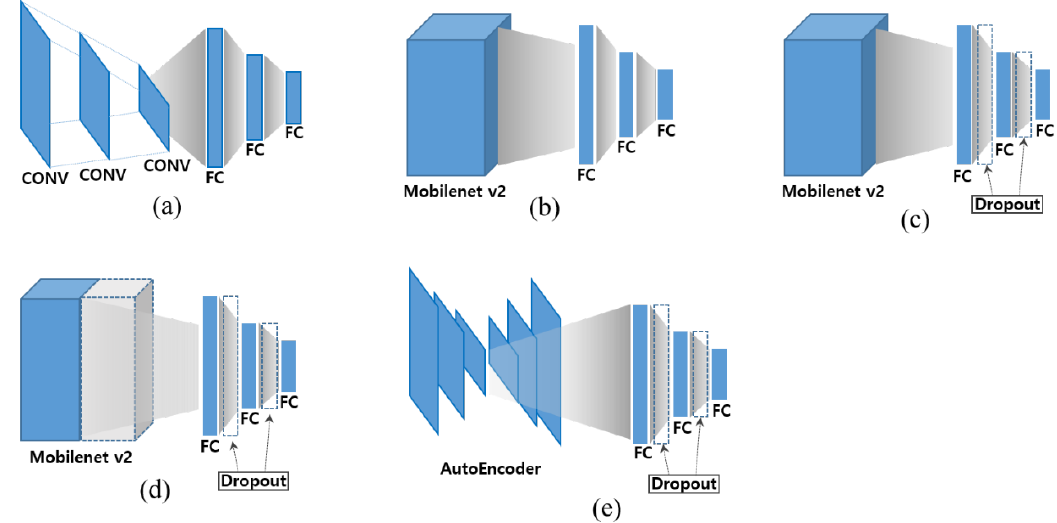
Figure 2. Four-corner prediction models. ( a ) is baseline model and ( b ) is a hybrid model with Mobilenet. ( c ) is a hybrid Mobilenet with dropout. ( d ) is a hybrid model that uses only the feature extraction layers of the Mobilenet. ( e ) is a hybrid model using autoencoder.